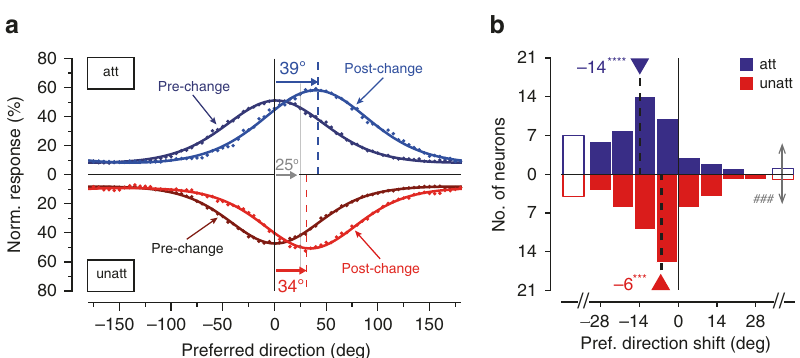
Fig. 2 Quanti fi cation of attention effect on MT neural responses. a Population response curves: population responses (Fig. 1b – c) averaged across a pre-change time interval from − 700 ms to 0ms (black points) and a post-change interval from + 100 to + 200ms (colored points) in the attended (top panel) and unattended (bottom panel) condition. In each attention condition we fi tted these time-averaged, pre- and post-change population responses with von Mises functions (solid curves). The dashed lines in each attentional condition indicate the location of the population ’ s peak response following the direction change of 25°. Error in the peak location obtained from the bootstrap procedure was 0.1° for pre-change (attended), 0.6° for post-change (attended), 0.2° for pre-change (unattended), and 0.4° for post-change (unattended) (see Methods for details). b Distribution of direction tuning curve shifts caused by attended (blue) and unattended (red) direction changes of + 25° for a population of MT units ( n = 52 units). The median values and the corresponding p values are labeled (*** p = 0.0005; **** p = 0.0000004 two-sided Wilcoxon ’ s signed-rank test for distribution with a median of 0; ### p = 0.001 paired two-sided Wilcoxon ’ s signed-rank test). Un fi lled bars represent units for which the magnitude of tuning shift was greater than 40°. The sign convention is that positive and negative values denote clockwise and counterclockwise displacements, respectively (Supplementary Note 1). Source data are provided as a Source Data fi le.